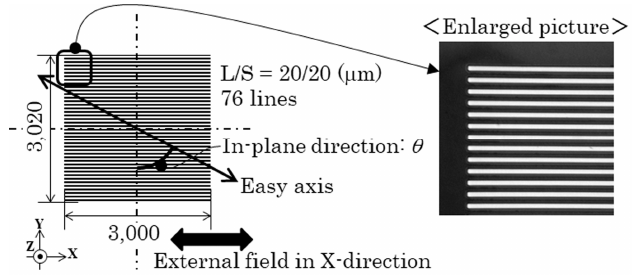
Figure 1. Layout of the many-body element on a glass substrate.